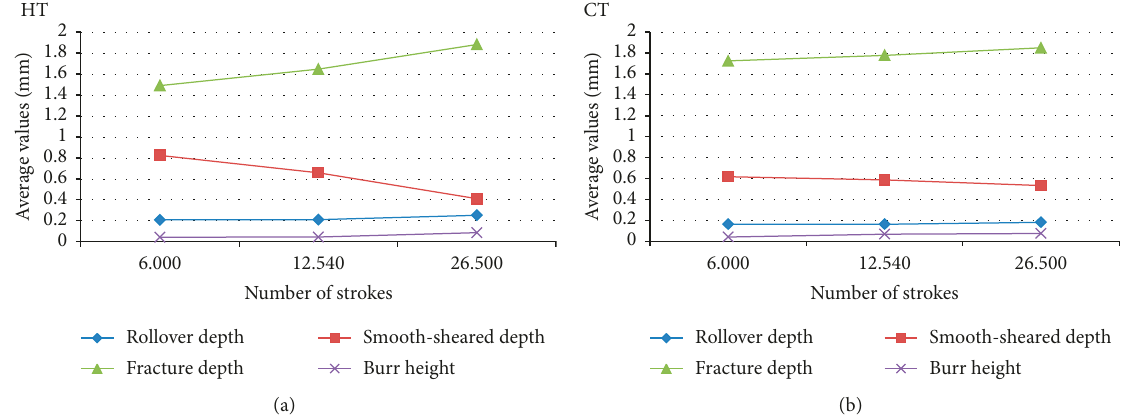
Figure 14: Average values of geometry of the cut surface of the holes of the control arm part (circular hole, Ø6.2 mm in diameter).